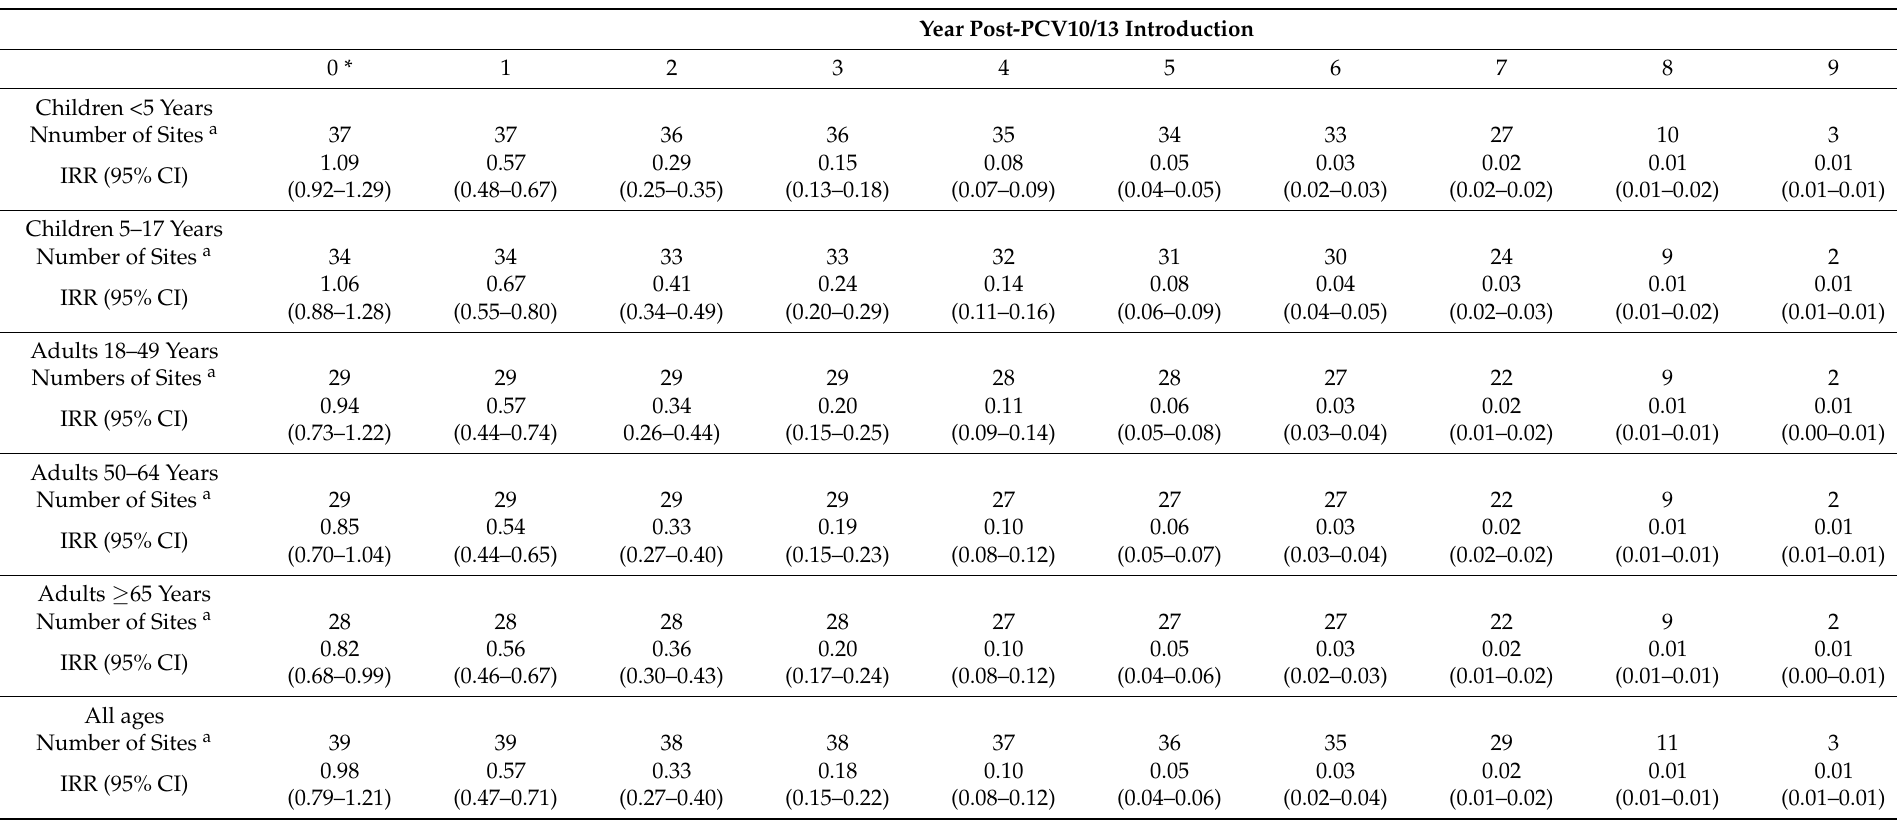
Table 2. Serotype 1 invasive pneumococcal disease all-site weighted average incidence rate ratios comparing the annual post-PCV10/13 incidence rate to the average pre-PCV10/13 incidence rate by age